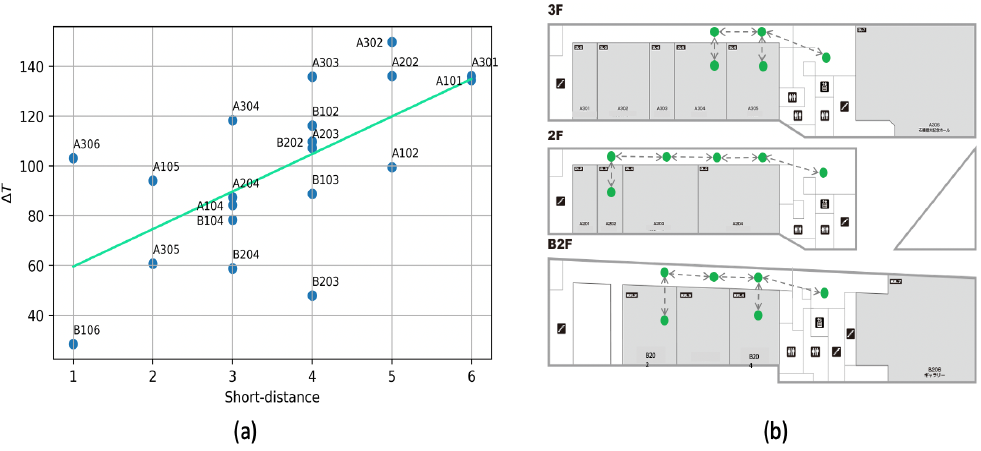
Figure 9. ( a ) Result of linear regression of the shortest-distance in the graph and the µ value of ∆ t , where the value of a, b are estimated to be 14.46, 26.7, respectively; ( b ) Several shortest distance examples between rooms and elevator in our